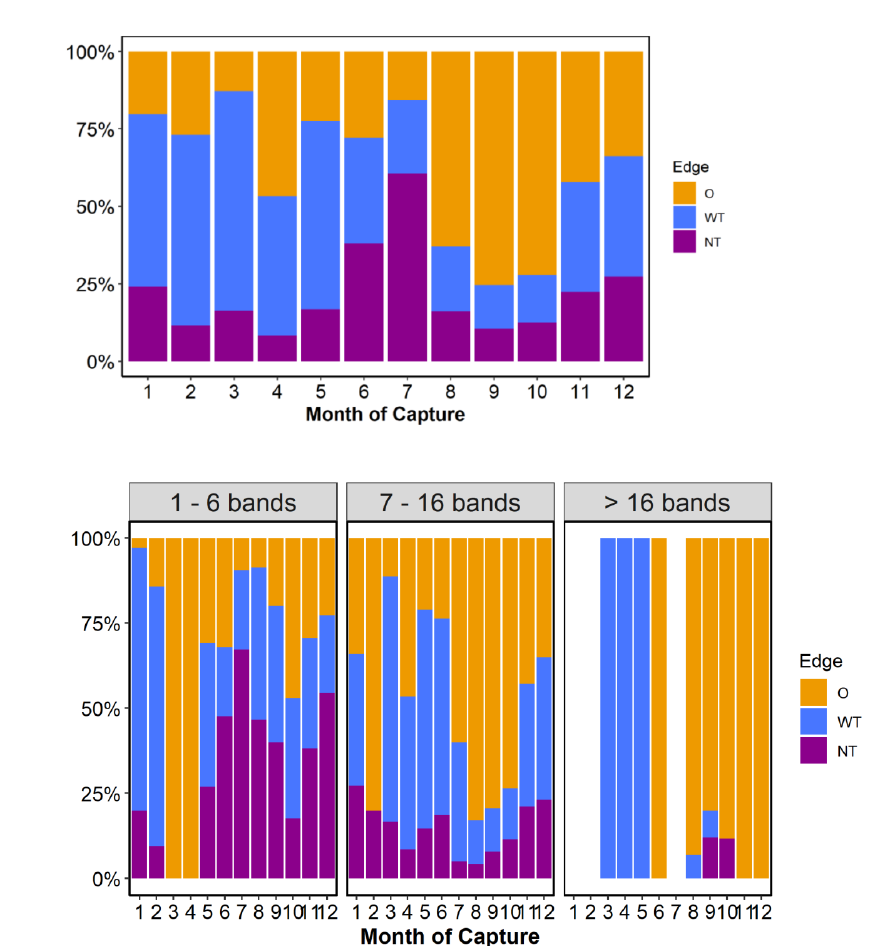
Figure 6. Percent marginal edge type by month, ( a ), and by month and age group (number of annual bands binned), ( b ). Months 3–4 for bin 1, month 2 for bin 2, and months 11–7 for bin 3 have a low number of samples (5 or less). Marginal edge type (O = opaque, WT = wide translucent, and NT = narrow translucent).